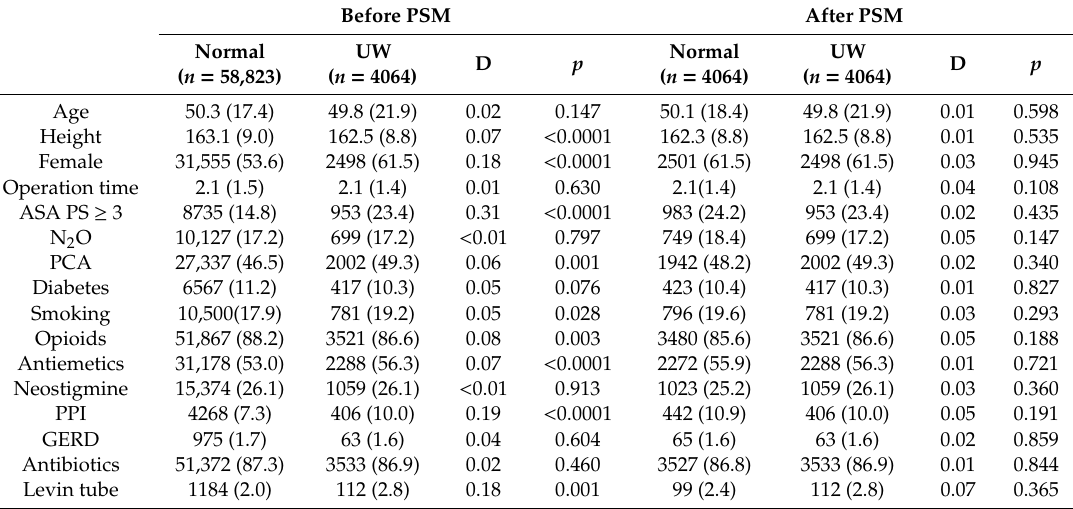
Table 3. Baseline characteristics of normal-BMI and underweight subjects, and comparison before and after propensity score matching. Before